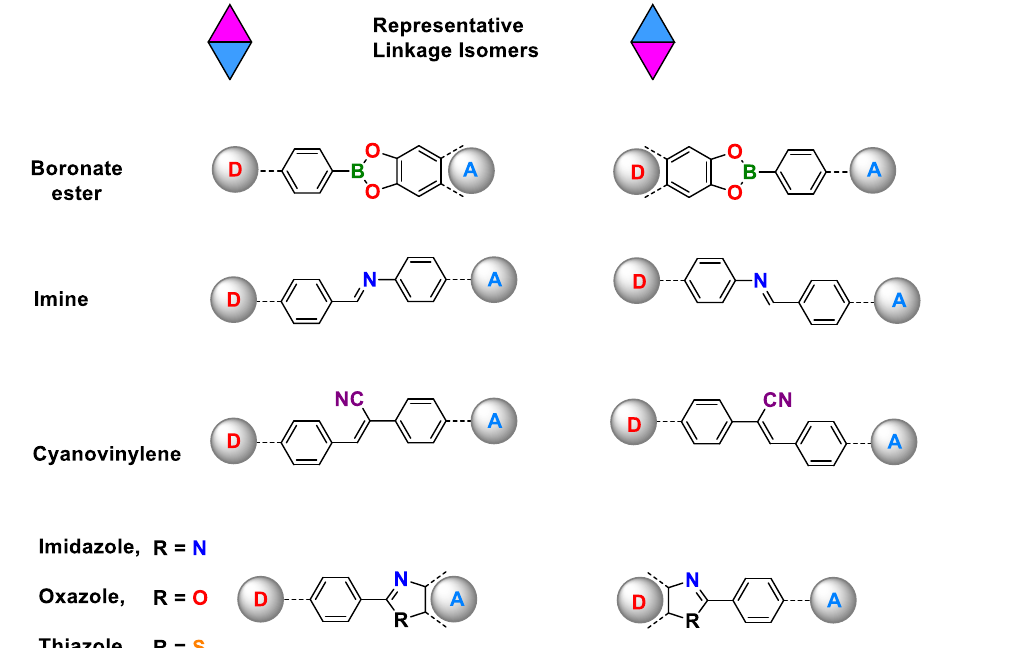
Fig. 6 | Scope of the theory. Representative linkages which show constitutional isomerism in